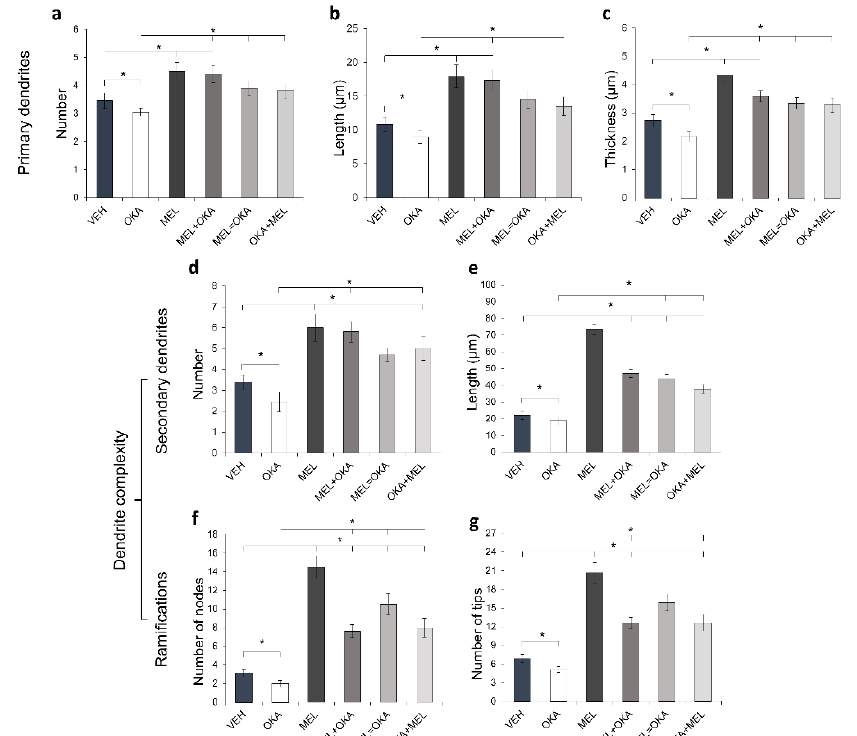
Figure 6. Morphometric analysis of dendritic arbors from hilar hippocampus treated with okadaic acid and melatonin. Treated rat hippocampal organotypic cultures were fixed and 50 µ m cryosections were processed for specific detection of somatodendritic MAP2 by immunohistochemistry. Acquired images were analyzed by the modified Sholl method to measure primary dendrite properties: ( a ) number, ( b ) length and ( c ) thickness, and dendrite complexity: ( d ) number and ( e ) length of secondary dendrites, as well as ( f ) number of nodes and ( g ) number of tips. The treatments corresponded to vehicle (VEH), 45 nM okadaic acid (OKA), 100 nM melatonin (MEL), MEL before OKA (MEL + OKA), simultaneous MEL and OKA (MEL = OKA) or OKA before MEL (OKA + MEL). Measurements of 20 neurons per treatment are presented as the mean ± SEM and compared through ANOVA on Ranks and Student-Newman-Keuls test for multiple comparisons. * depicts p < 0.05.